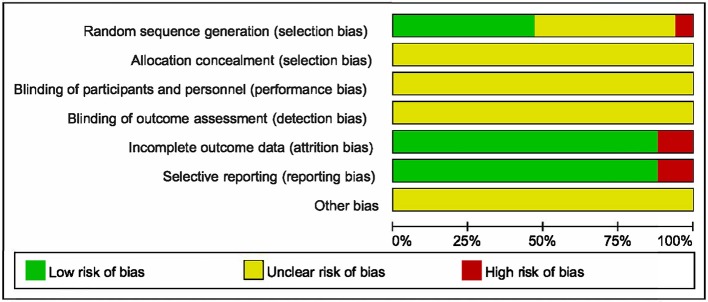
Risk of bias graph.